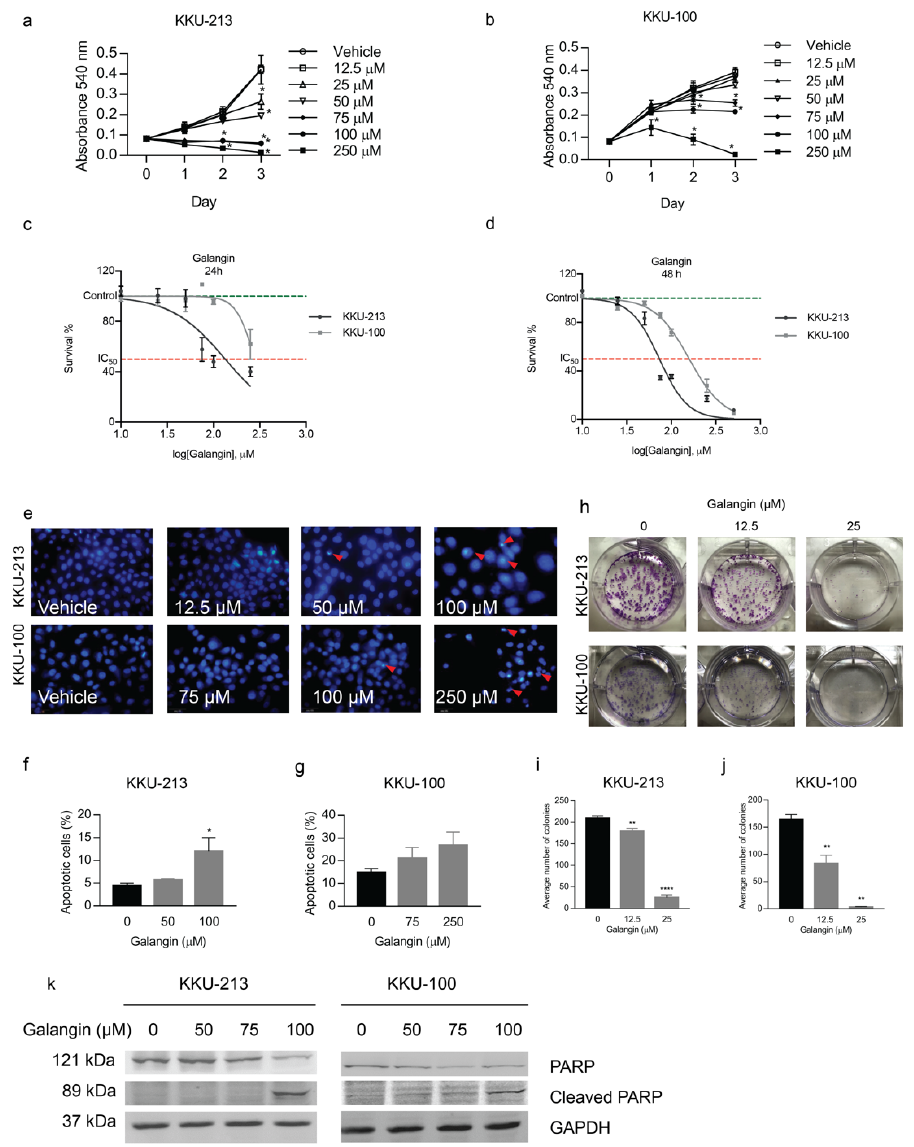
Figure 1. Effect of Galangin on cholangiocarcinoma cell proliferation. The cytotoxic effect of Galangin on ( a ) KKU-213, ( b ) KKU-100, and CCA cell lines were determined by MTT assay. The IC 50 values were calculated using the dose-response curve for ( c ) 24 h and ( d ) 48 h of treatment. ( e ) Detection of apoptosis by DAPI staining after Galangin treatment in CCA cell lines in various concentrations. The number of apoptotic cells were quantified in ( f ) KKU-213 and ( g ) KKU-100 cell lines through FACS analysis. ( h ) Representative images of colony formation and quantification for average number of colonies on ( i ) KKU-213 and ( j ) KKU-100 cells upon Galangin treatment at 10 and 25 µ M. ( k ) Effect of Galangin on protein involved in apoptosis. Cellular proteins were analyzed by Western blot assay for the expression of PARP and cleaved PARP. Values represents the mean ± SEM of three independent experiments, * p ≤ 0.05, ** p ≤ 0.01, **** p ≤ 0.0001 compared with the untreated